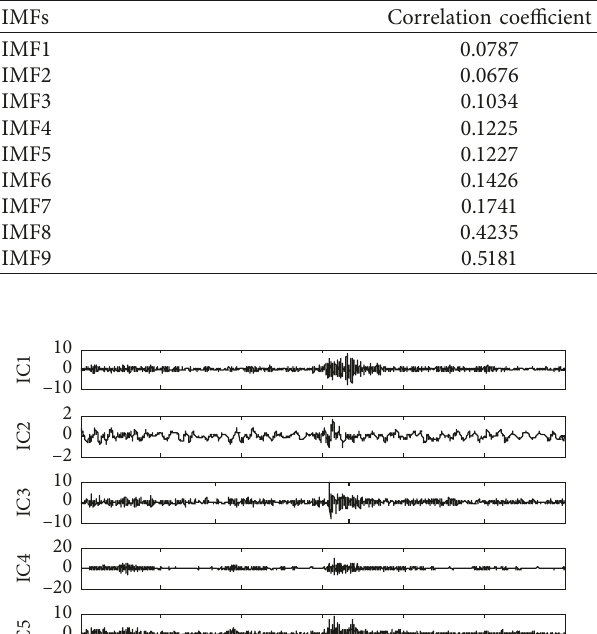
Table 5: The correlation coefficient.